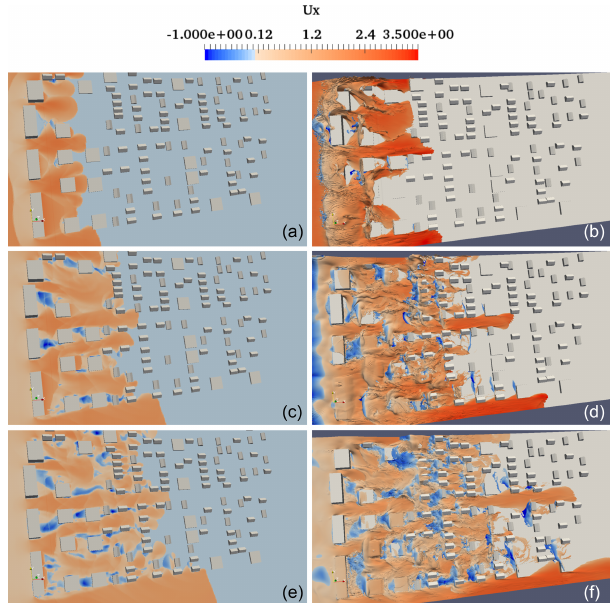
Figure 13. Snapshots of the simulation near line A, colored by cross-shore velocity, at three different times (from top to bottom): t = 25 . 9s, t = 27s, and t = 28 . 1s. (a, c, e) Geoclaw; (b, d, f) Open- FOAM.